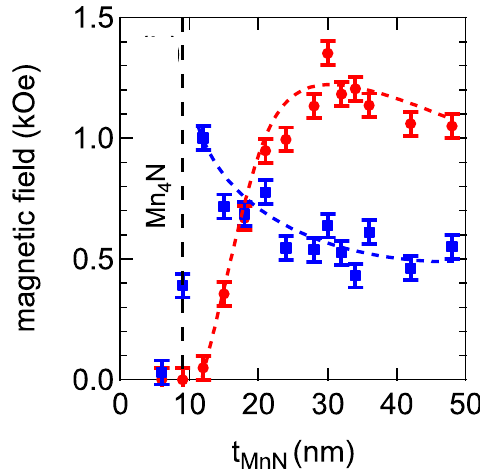
Figure 4. Variation of the exchange bias (solid red circles) and coercive field (blue squares) as a function of MnN thickness. (Reproduced with permission from M. Meinert, Physical Review B; published by the American Physical Society, 2015) [14].